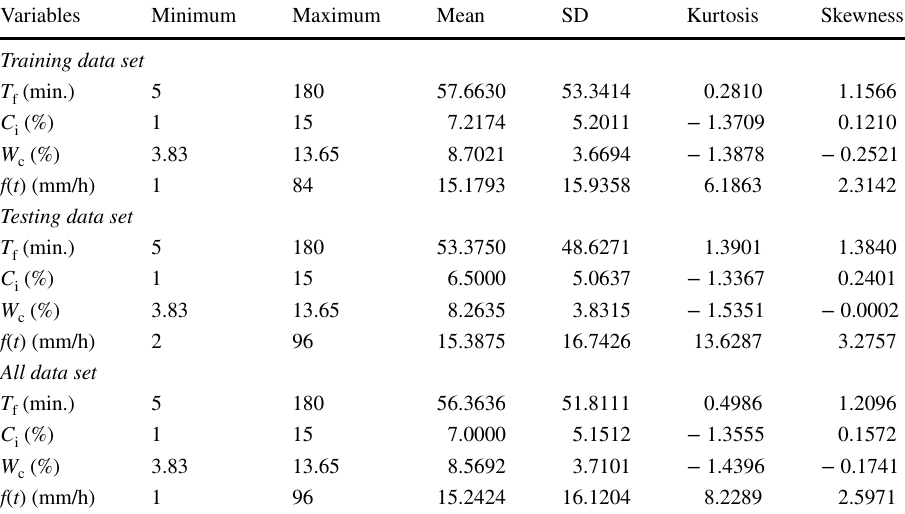
Table 2 Features of the data used